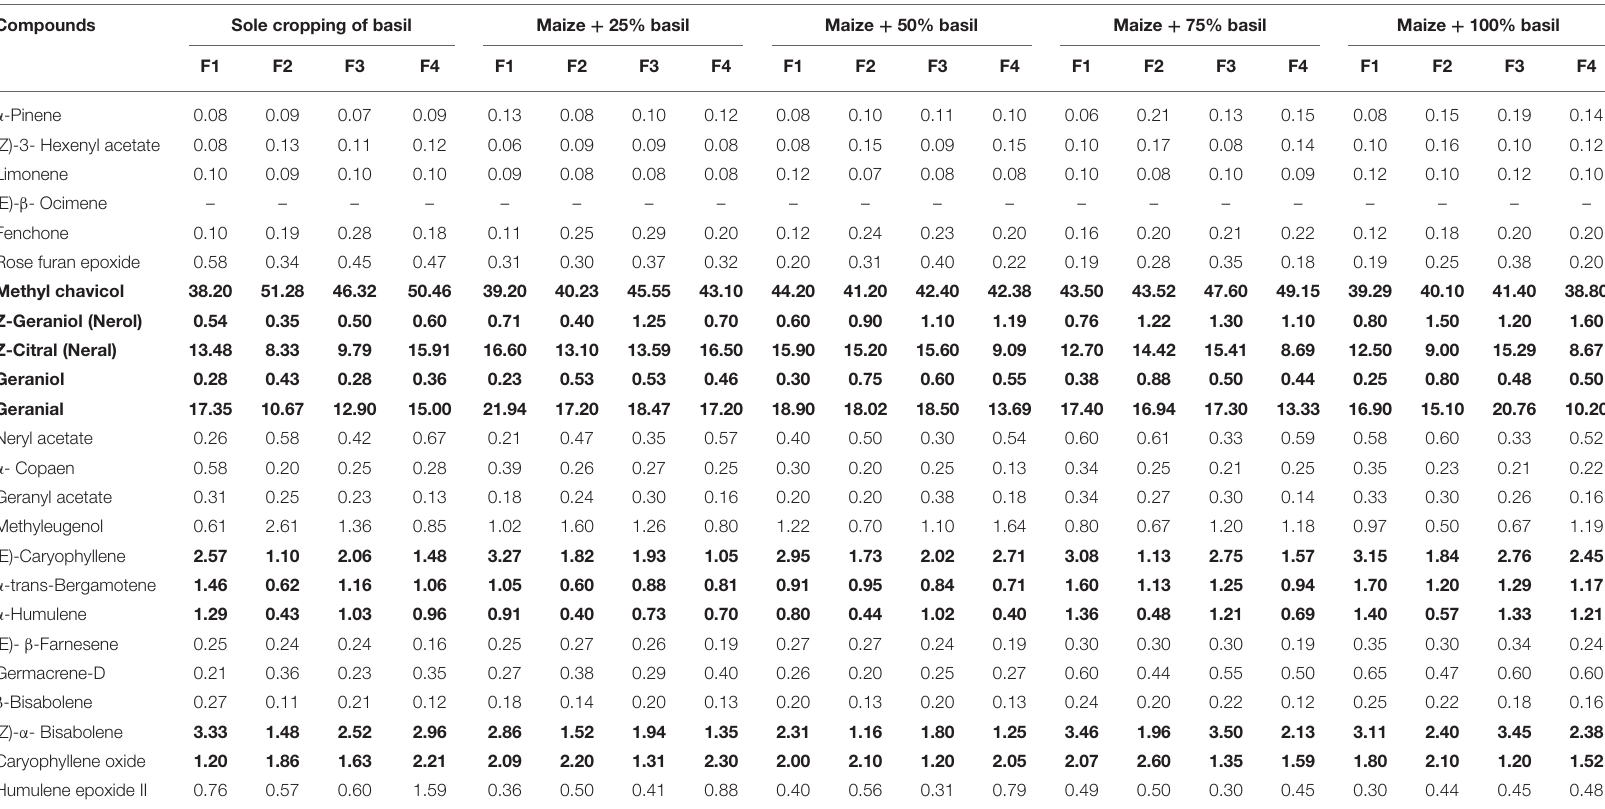
TABLE 5 | Essential oil constituents in basil grown with different sources of nitrogen under different patterns of cropping during 2019 growing season (expressed on relative percentage basis).